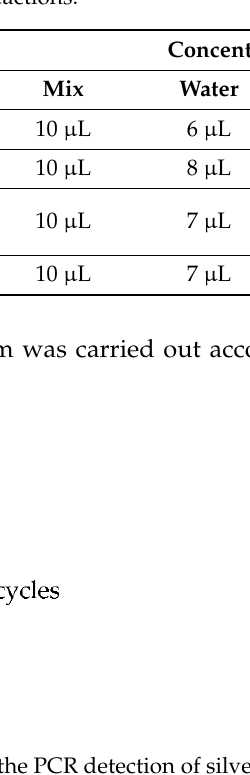
Table 2. Components of the PCR reactions.